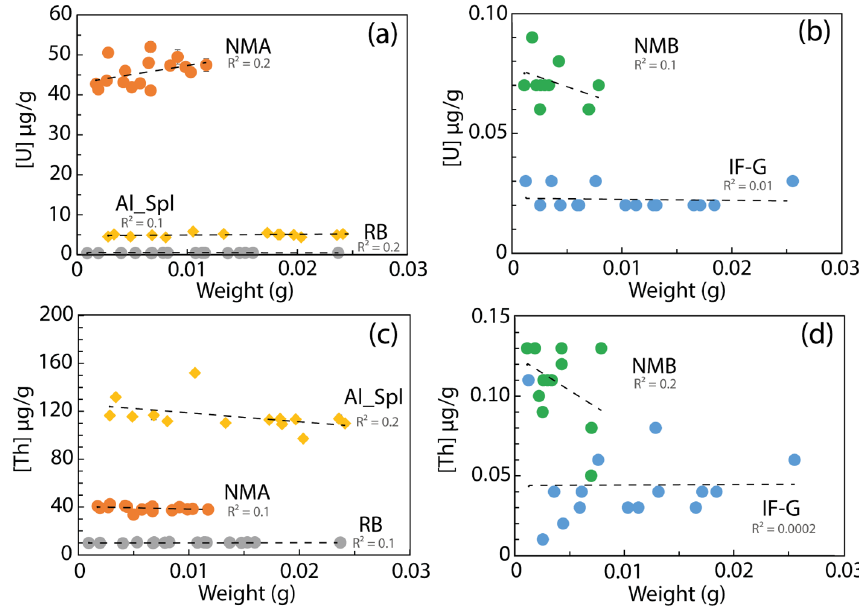
Figure 5. U and Th concentration evolution with the mass of the dissolved sample. U concentration for (a) NMA, Al-Spl, and RB samples and (b) NMB and IF-G samples; Th concentration for (c) NMA, Al-Spl and (d) NMB and IF-G